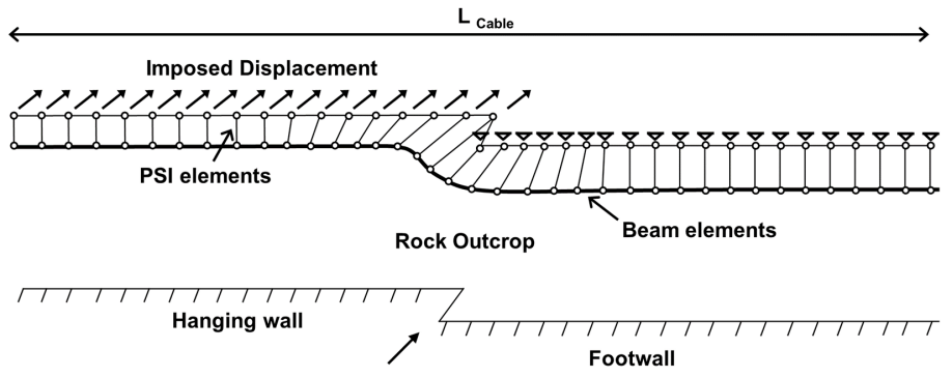
Figure 2. Proposed numerical model for cable-fault intersections.